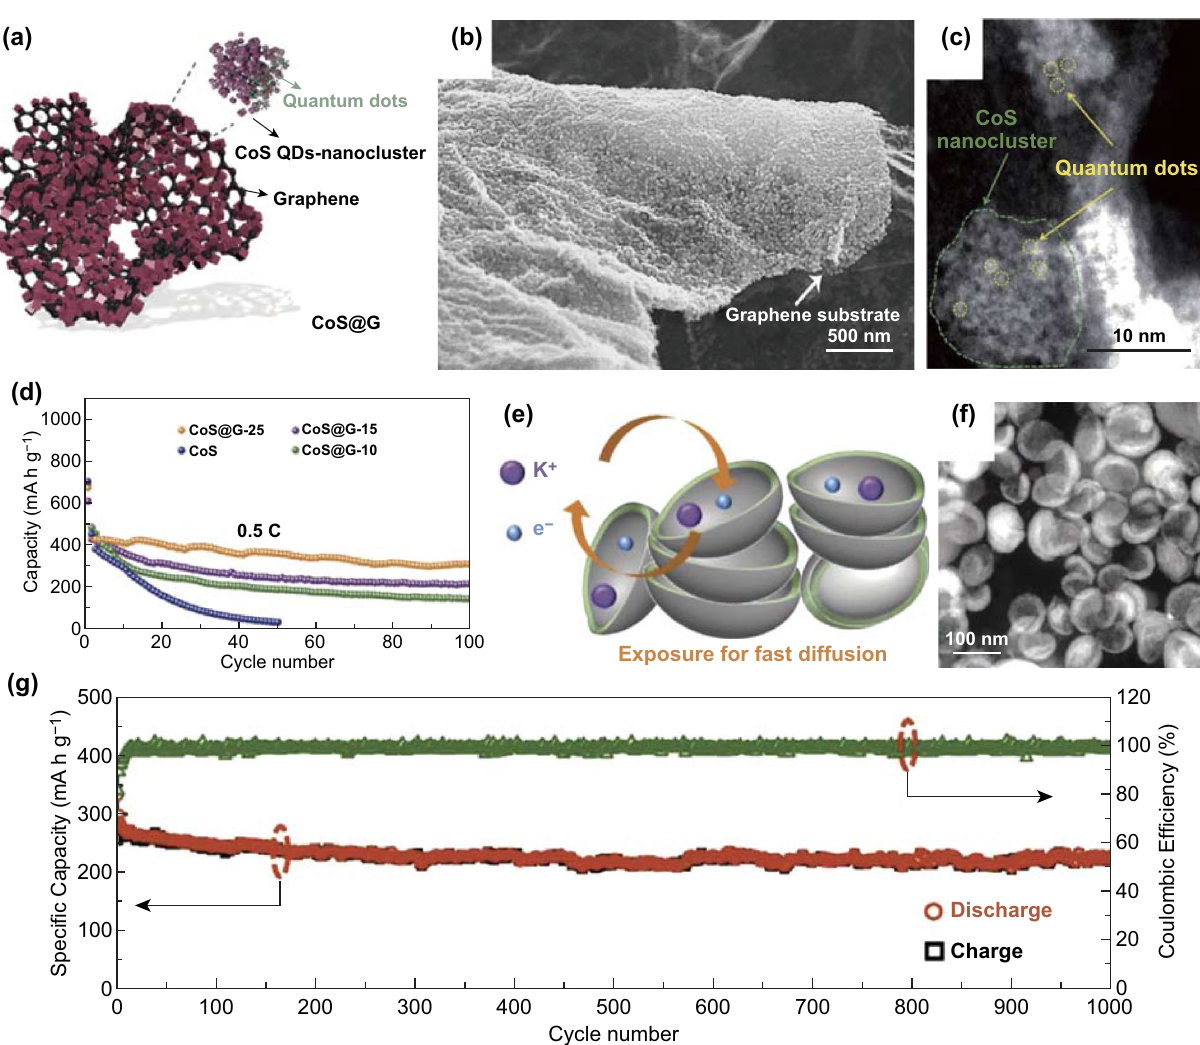
Fig. 4 a Schematic illustration of CoS@G composite. b SEM and c dark field images of the obtained sample. d Cycling capacities of CoS@G- 25 anode compared with other samples. Reproduced with permission from Ref. [41]. Copyright 2017, John Wiley and Sons. e Schematic diagram of PMC with fast ion and electron diffusing. f HAADF-STEM image of PMC. g Long-term cycle performance as well as (C.E.) at 1.0 A g −1 over 1000 cycles. Reproduced with permission from Ref. [43]. Copyright 2018, John Wiley and